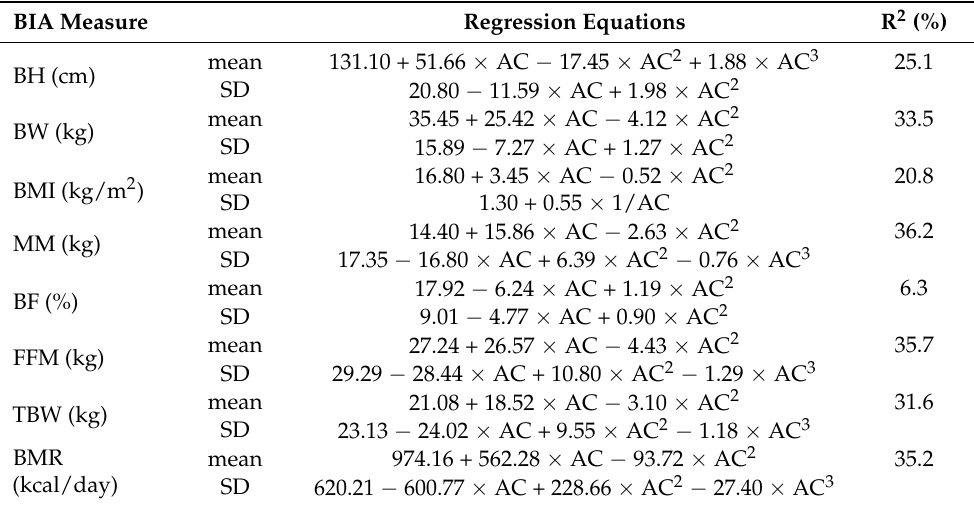
Table 3. Regression equations for the mean and SD of body height, weight, body mass index, skeletal muscle mass, percentage of body fat mass, fat-free mass, total body water and basal metabolic rate by competitive age category in male soccer players. BIA Measure